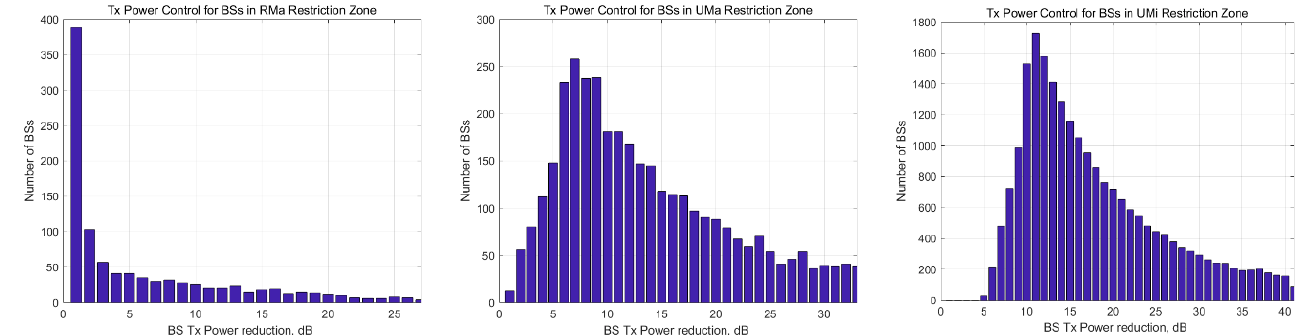
Figure 22. The size of the exclusion and restriction zones for different scenarios using omni antenna. The red lines show the exclusion zone (no BSs can be deployed) and the pink lines show the restriction zone (BSs can be deployed with Tx power control). The blue lines indicate that BSs can be deployed in these areas without restrictions.